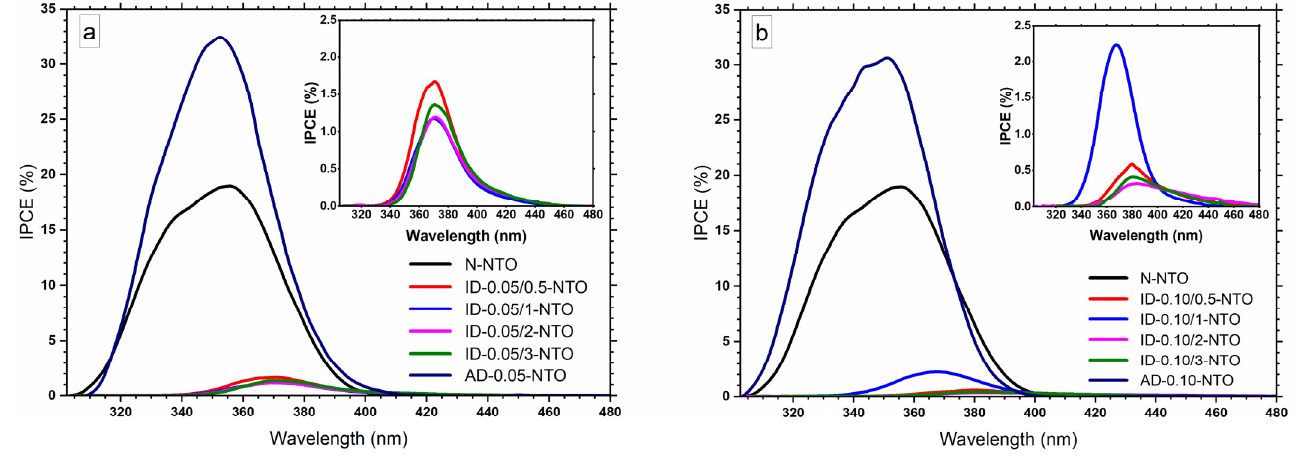
Figure 4. Incident photon to converted electron spectra (IPCE) of set of samples ( a ) N-NTO, ID- 0.05/y-NTO, AD-0.05-NTO, and ( b ) N-NTO, ID-0.10/y-NTO, AD-0.10-NTO.